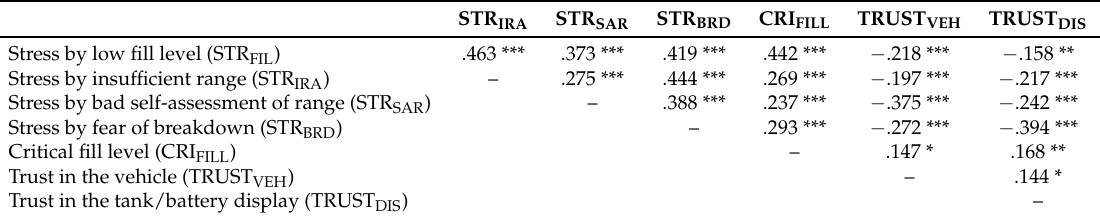
Table 4. Kendall’s τ correlation coefficients for stress factors, critical fill level and trust in vehicle and in tank/battery display (* corresponds to p < .05, ** corresponds to p < .01, *** corresponds to p < .001). STR